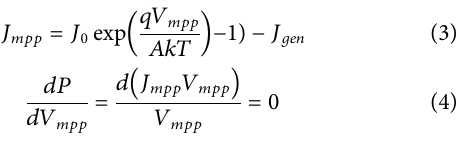
and the absorption of the optimal luminophore. The emission is a single wavelength at 1,050 nm. c